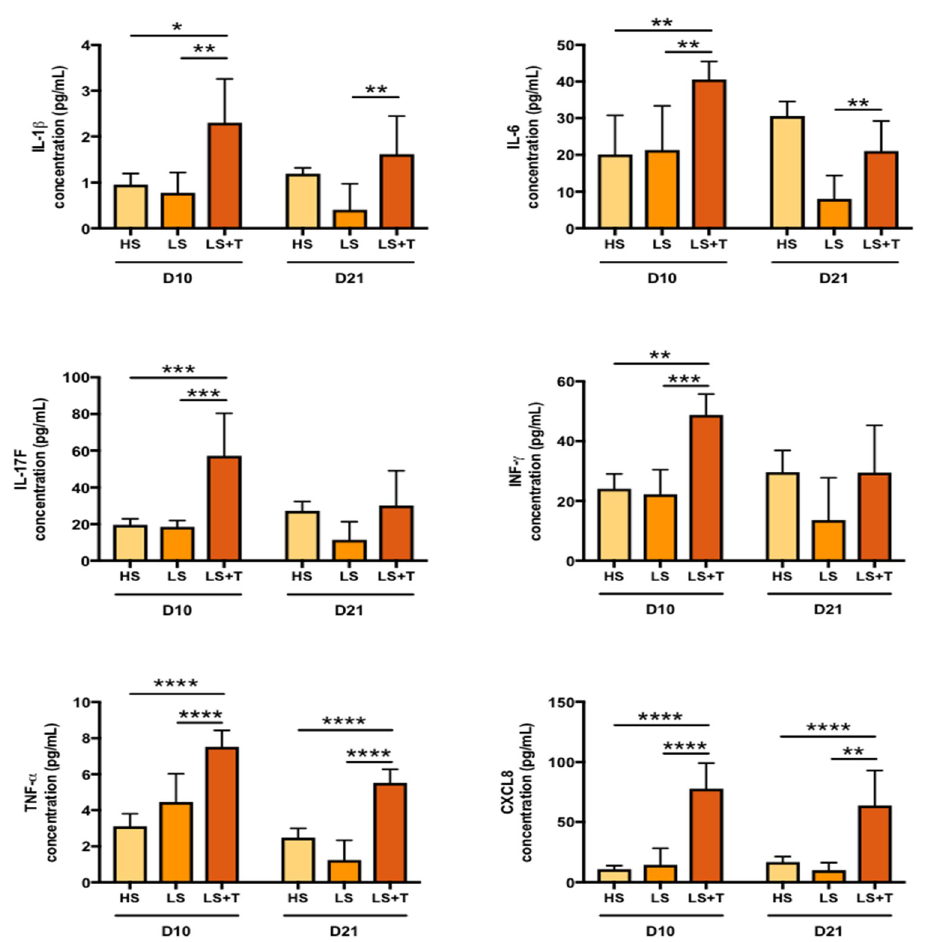
Figure 4. Increased secretion of proinflammatory factors generated by T cells in tissue-engineered lesional skin models. Analysis of protein expression of the culture supernatants of healthy (HS), lesional (LS), and lesional with T cells (LS + T) skin models at day 10 and 21 of the air-liquid culture. The values are presented as mean ± SD ( n = 3). Significant differences (* p < 0.05, ** p < 0.01, *** p < 0.001, **** p < 0.0001) are indicated by an asterisk.